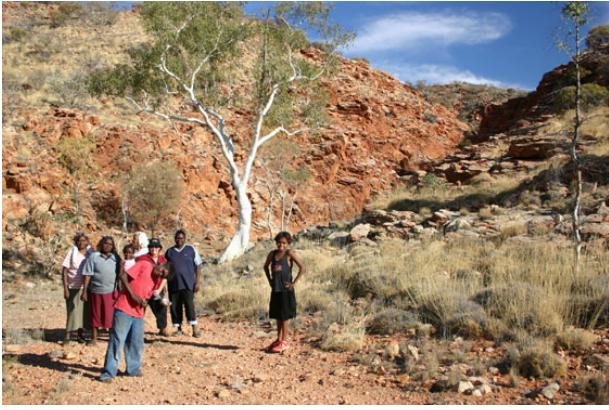
Fig. 5. Apmere or Arrernte country at Atneperrke (John Hayes rockhole). Veronica (center) with three Arrernte generations associated with this sacred site. The Atneperrke site is named for the fat-covered intestines of certain mammals. (Photo by T.